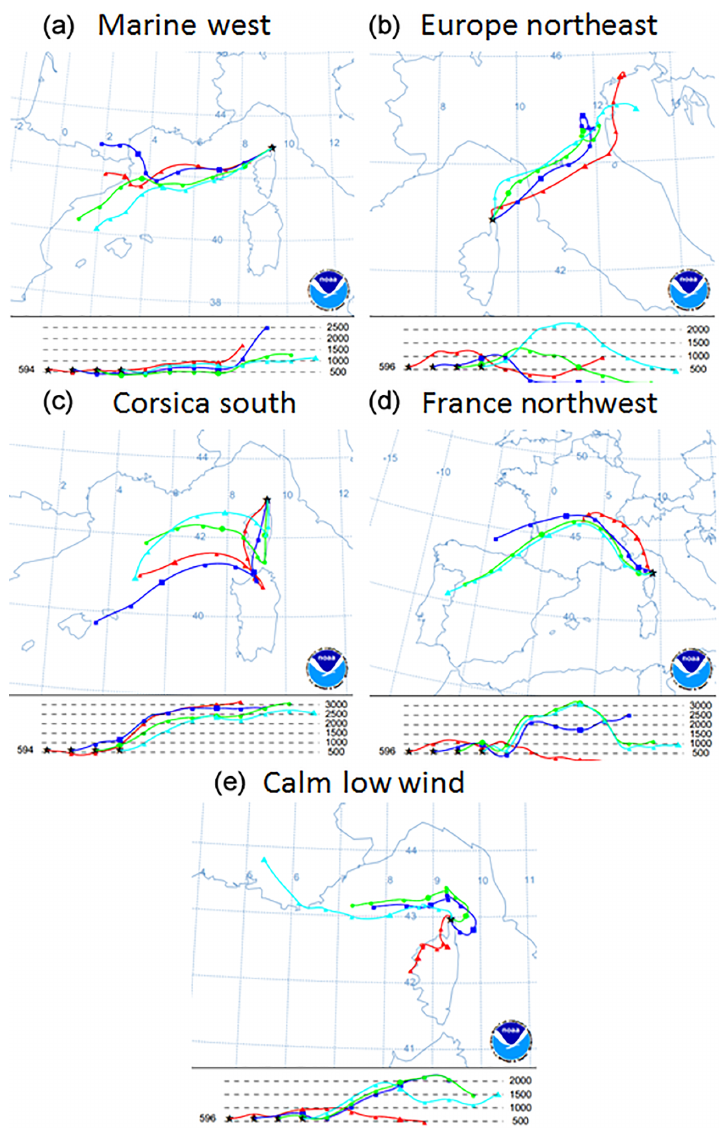
Figure 2. Five back-trajectory clusters identified for the ChArMEx SOP2 field campaign at Cape Corse. This classification was conducted using back trajectories calculated by the HYSPLIT model (NOAA-ARL). The five clusters are illustrated by example maps for four trajecto- ries (interval of 6h between each; time of arrival indicated by different colors of trajectory) for five single days representative of an isolated cluster (25, 21, 28, 30 and 18 July for marine west, Europe northeast, Corsica south, France west and calm low wind,